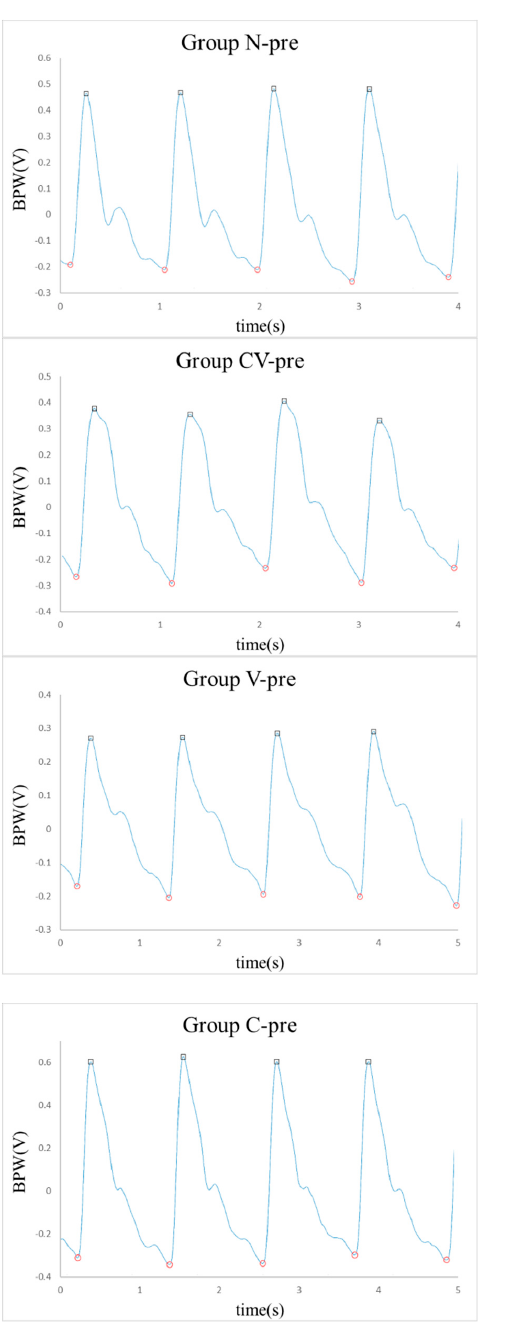
Figure 1. Typical BPWs measured (in arbitrary units).